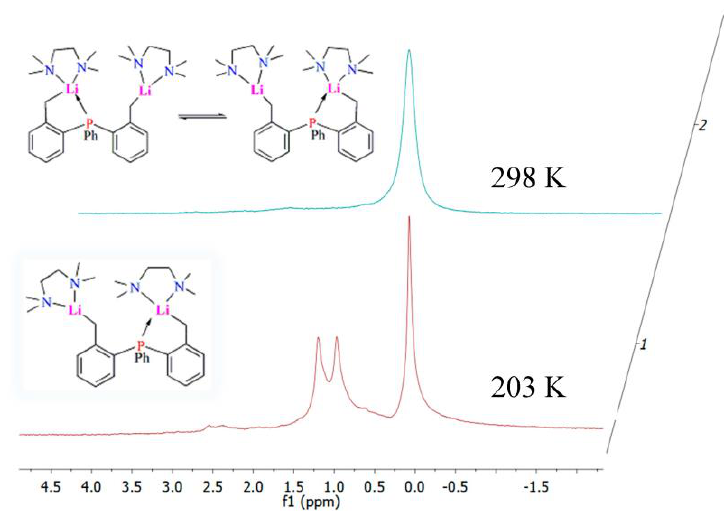
Figure 5. 7 Li NMR spectra in toluene-d 8 of 2-Li 2 at two different temperatures showing at the slow exchange regime two signals for the two lithium nuclei as a doublet at δ 1.08 and singlet at δ 0.08.